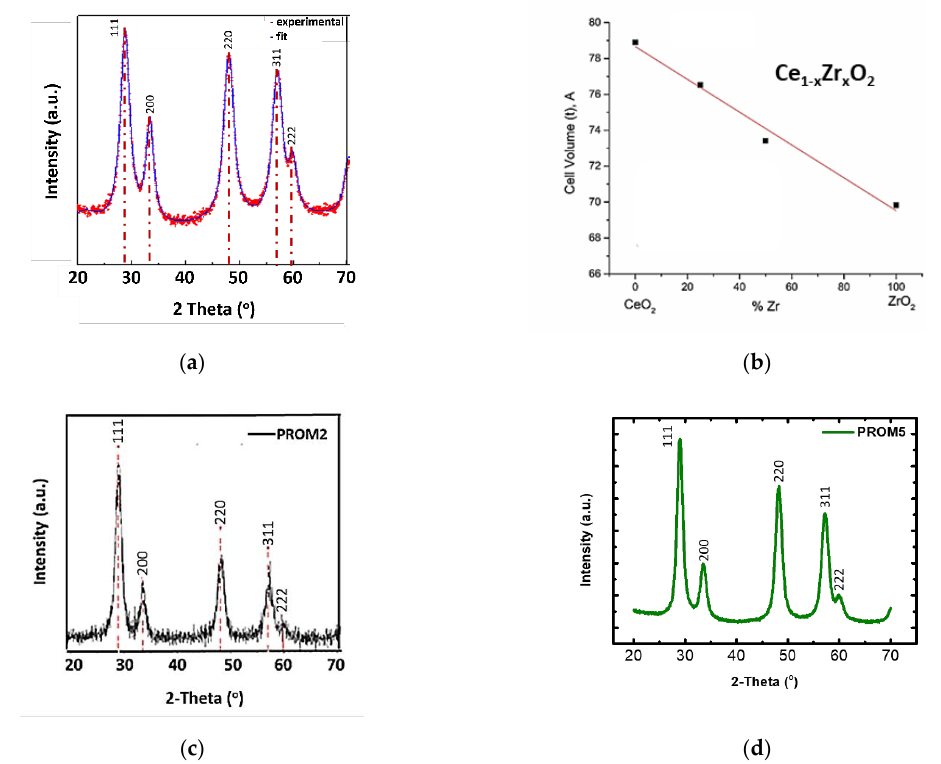
Figure 7. ( a ) XRD pattern (red dots) and fitting (blue line) of the Ce 0.68 Zr 0.32 O 2 (CZ) sample; ( b ) cubic crystal cell volume of various Ce-Zr solid solutions; ( c ) X-ray diffraction (XRD) pattern of PROM2; ( d ) XRD pattern of PROM5.